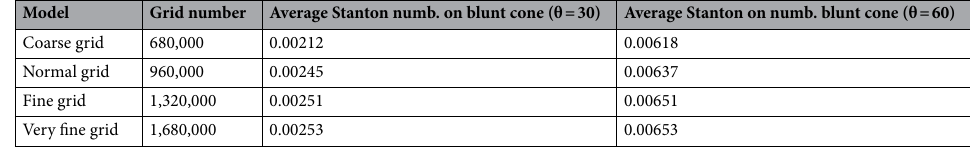
Table 1. Grid details.